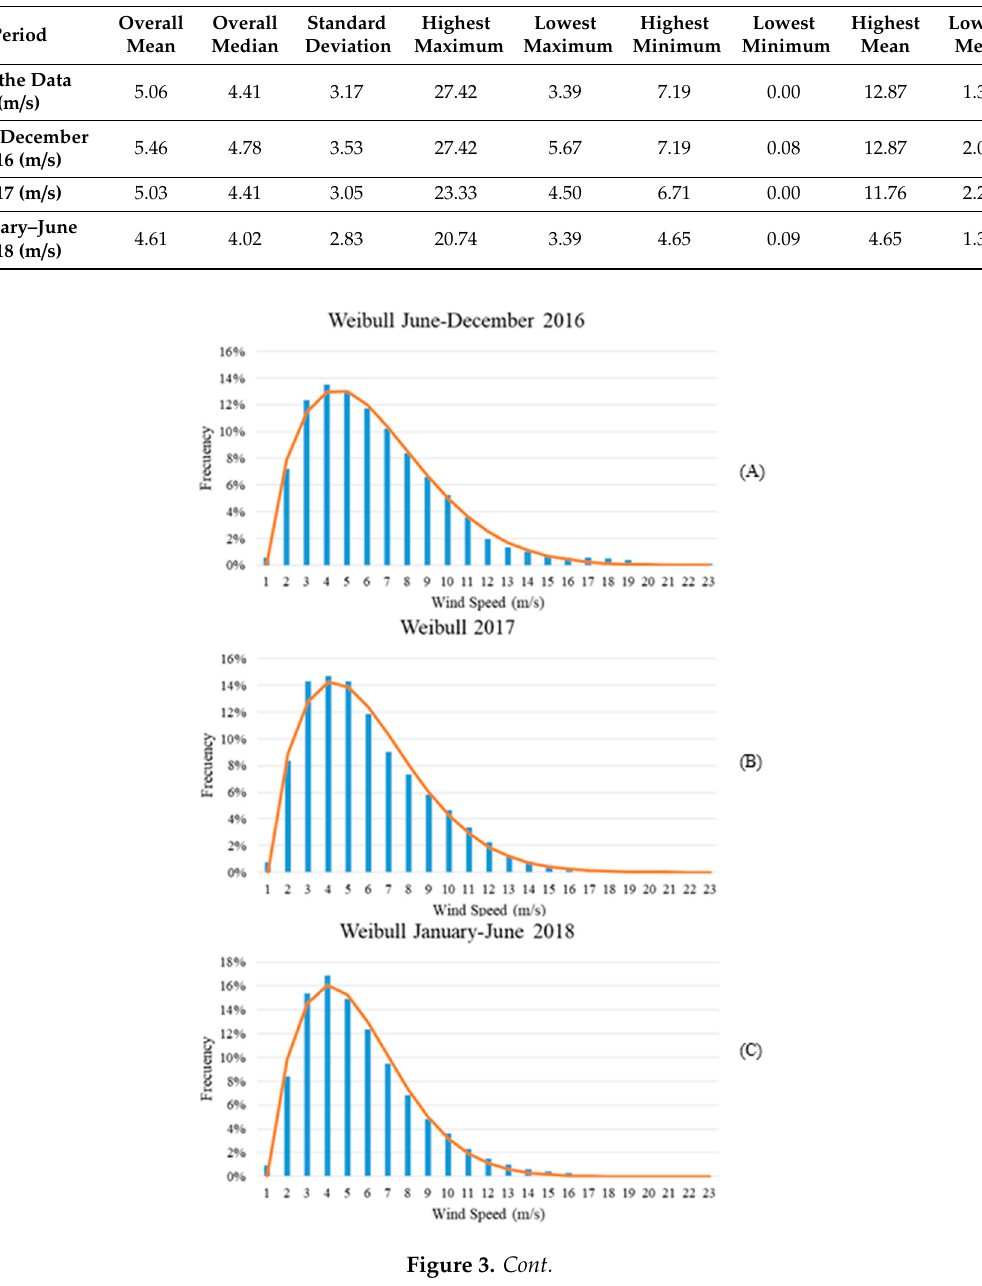
Table 3. Wind speed summary.